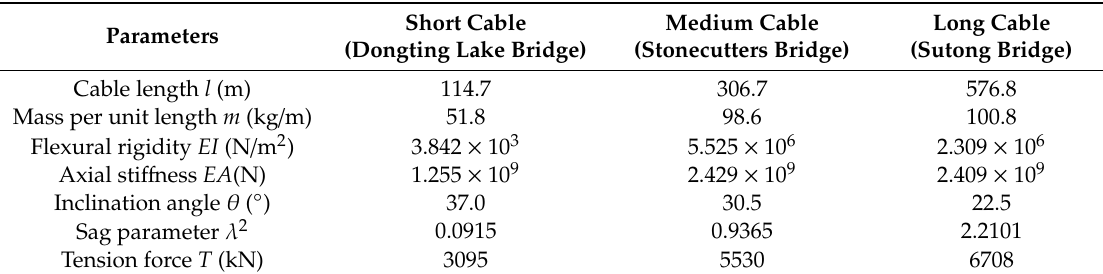
Table 4. Properties of three typical cables in cable-stayed